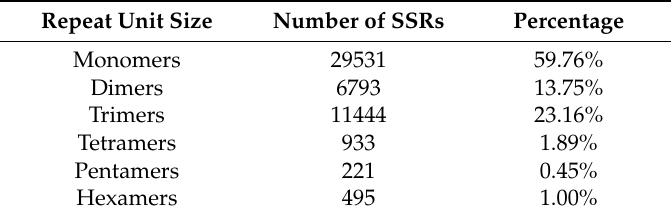
Table 4. The information of SSR derived from all unigenes.